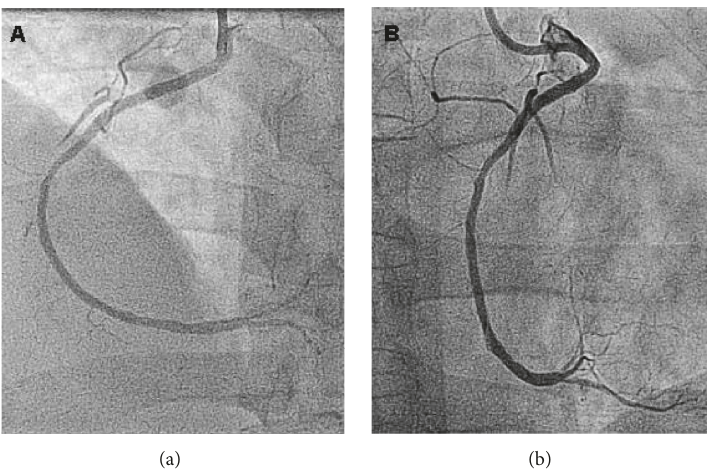
Figure 3: Post-PCI angiogram. RCA seen in both LAO (a) and RAO (b) views. Good poststenting result in proximal RCA (TIMI 3) but slow flow (TIMI 2) in RV marginal branches. RCA: right coronary artery; LAO: left anterior oblique; RAO: right anterior oblique; TIMI: thrombolysis in myocardial infarction; RV: right ventricular.